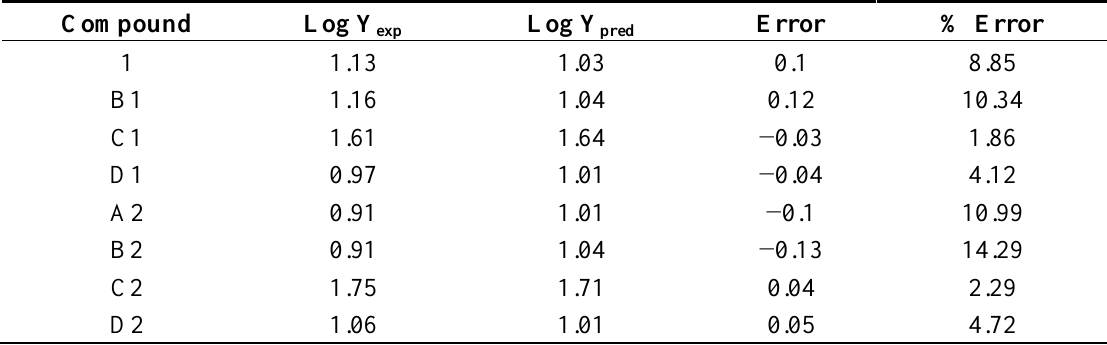
Table 5. Experimental and calculated antiradical activity, error and % error values of coumarin compounds with BPNN